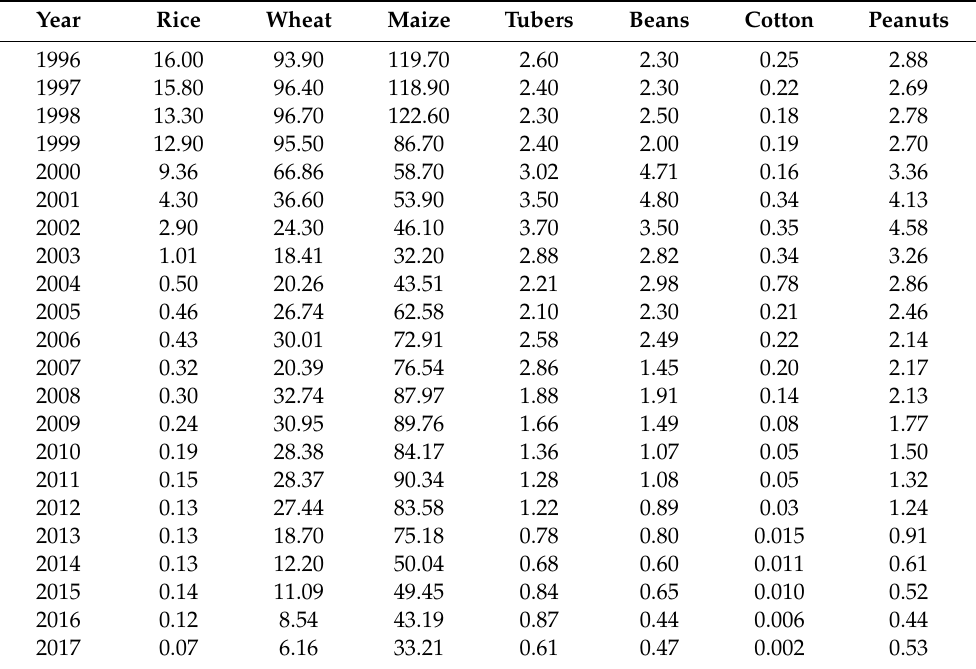
Table 2. Agricultural yield (10 4 t) of main crops from 1996–2017. Rice Beans